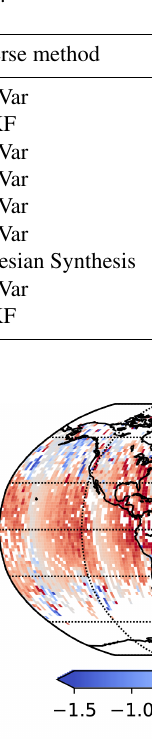
Table 3. Models that contribute to the multi-model median truth proxy data set.